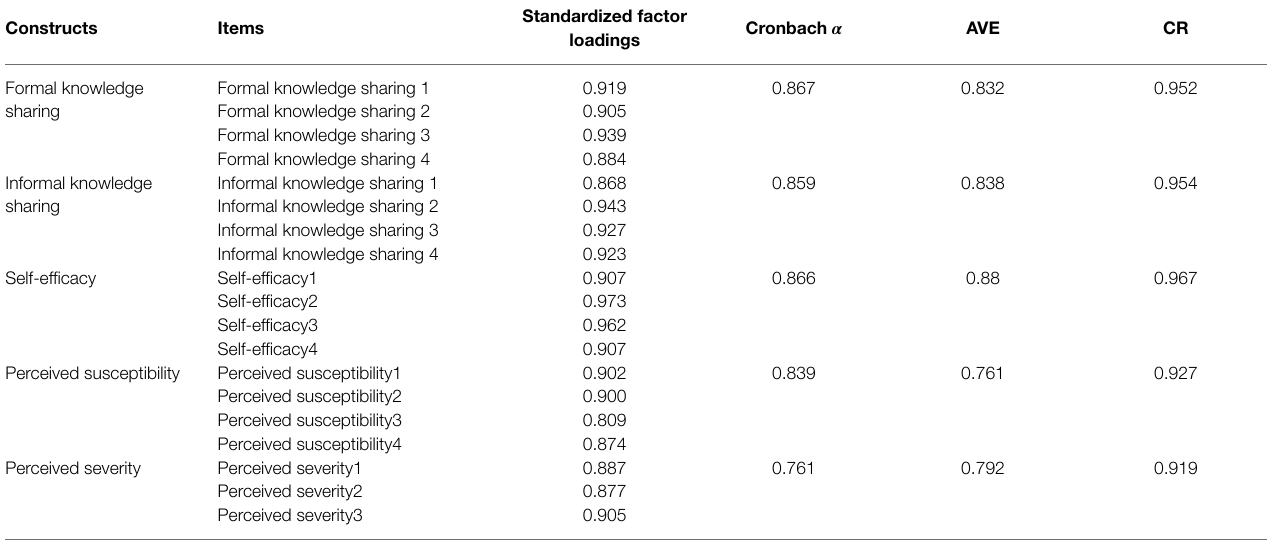
TABLE 2 | Construct reliabilities and